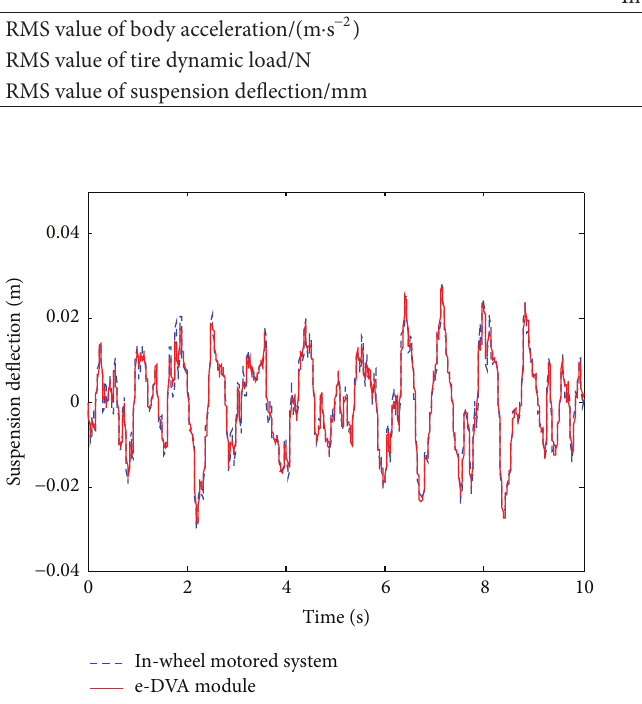
Figure 15: Suspension deflection variation with time.